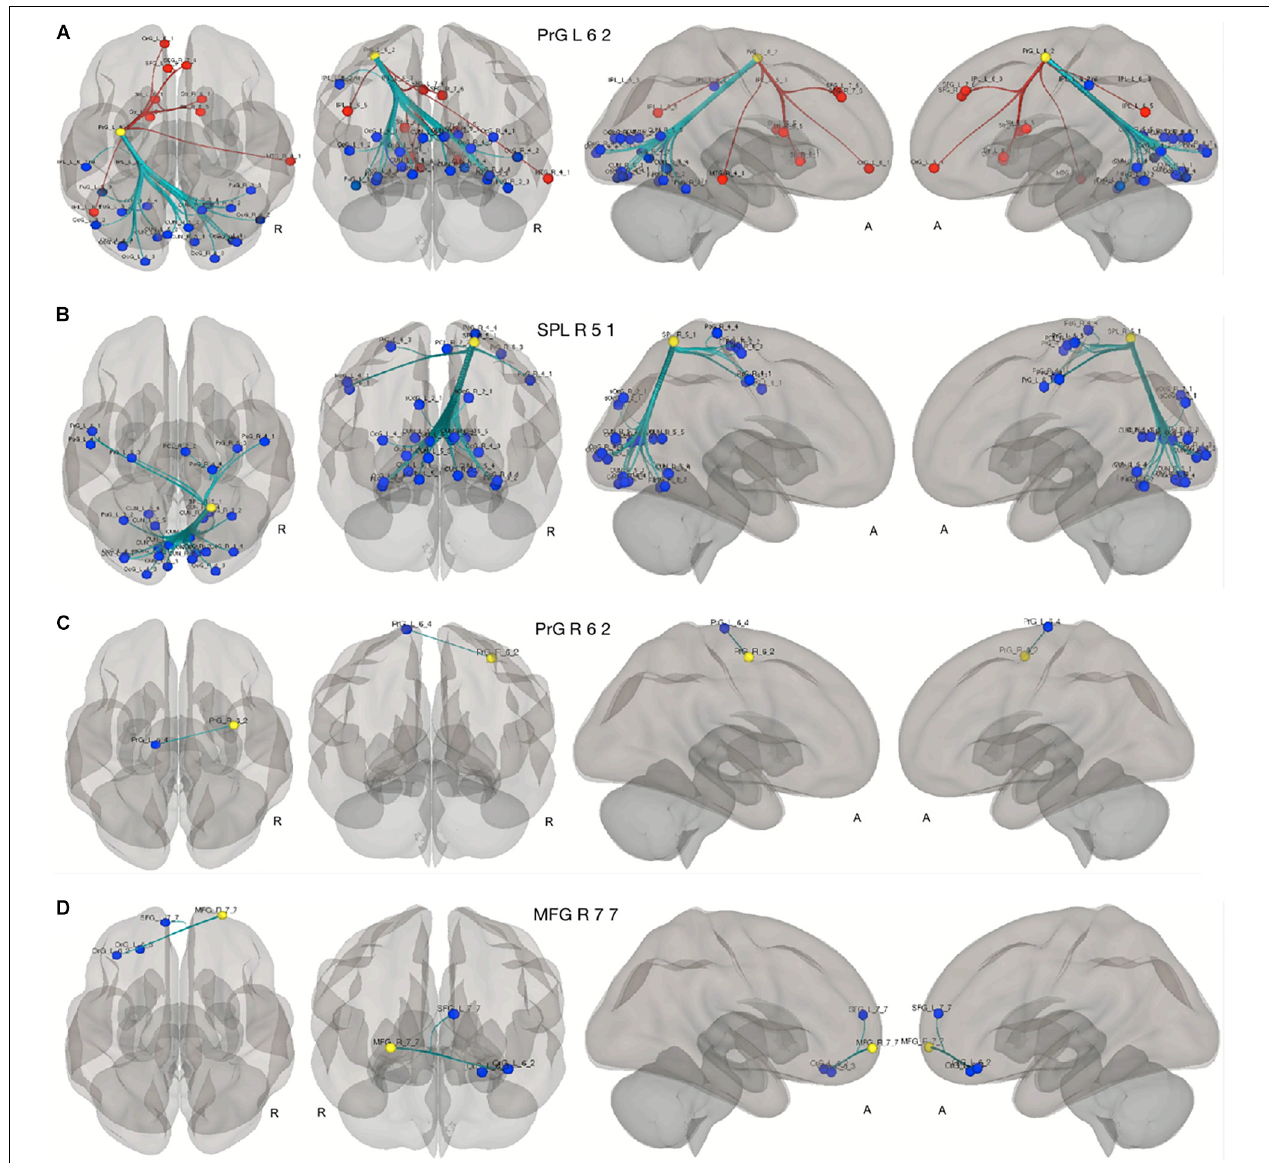
FIGURE 5 | Seed to ROI analysis of the compensatory ROIs. The yellow circles represent the compensatory ROIs. The colored circles depict the ROIs with a significant increase (blue) or decrease (red) of connectivity with the corresponding compensatory ROIs in our two contrasts. (A–C) young HC > senior HC and MCI ( p < 0.05, FDR-corrected). (D) Senior HC > MCI ( p < 0.05,